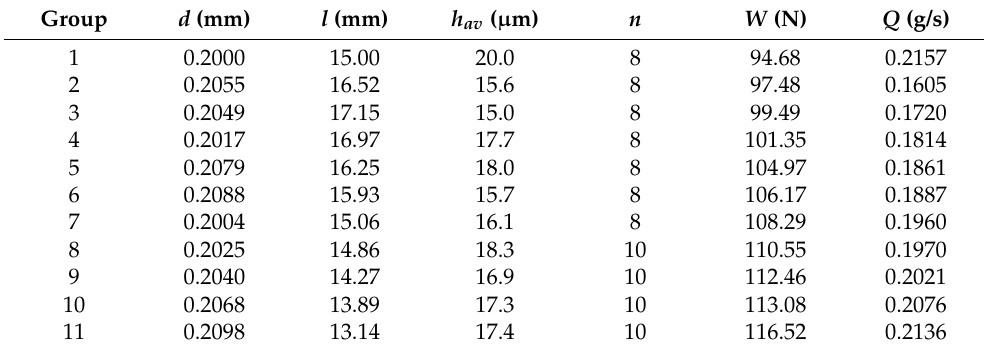
Table 4. Comparison of optimization results.